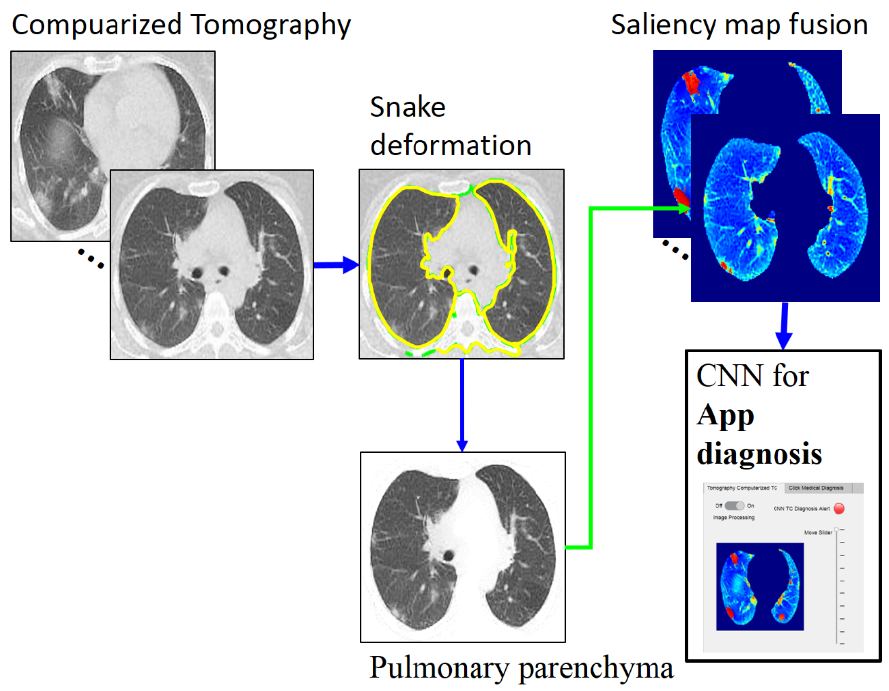
Figure 2. Overall method description, https://drive.google.com/drive/folders/1Q41lGFpawPvYmPZ8 SNK3sgsuvjs4kB45?usp=sharing (accessed on 3 March